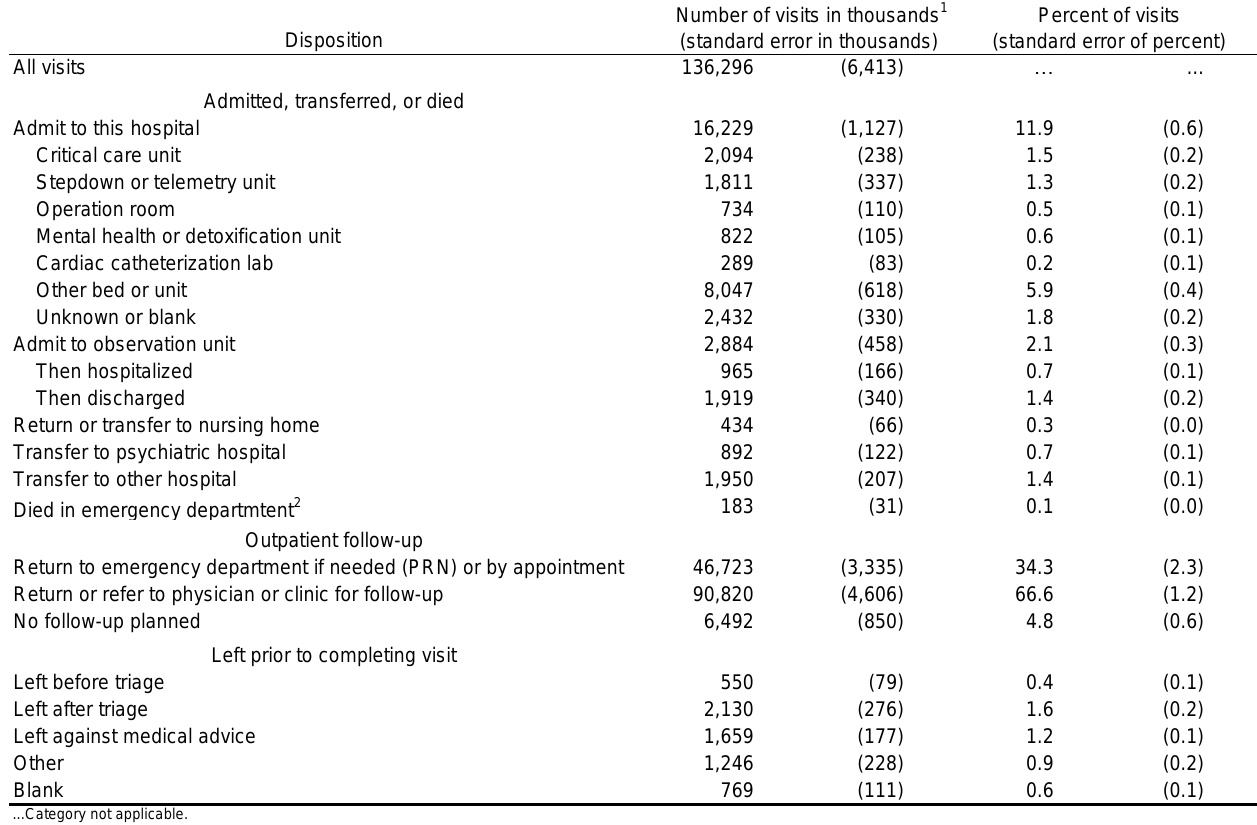
Table 24. Disposition of emergency department visits: United States, 2011